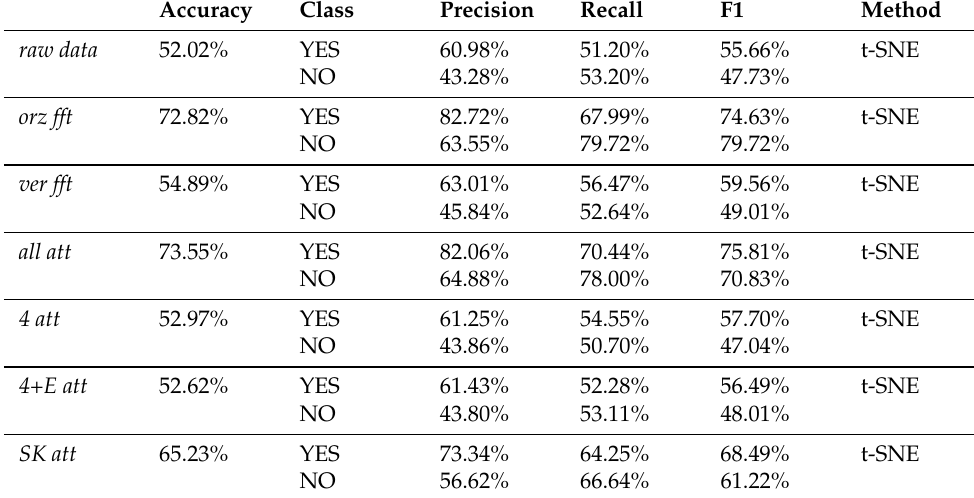
Table 7. K-Means—dynamic